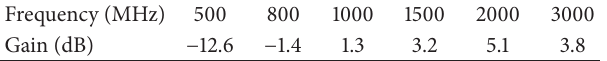
Table 3: Measured gain of the quasi-TEM horn